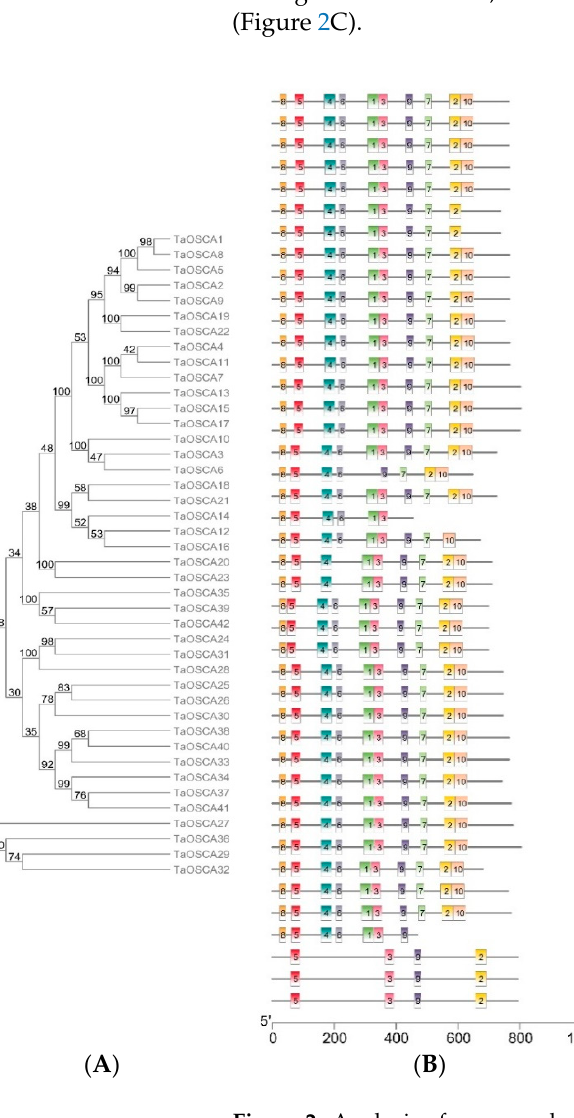
Figure 2. Analysis of conserved motifs and gene structure of T. aestivum OSCA genes. ( A ) Phylogenetic tree constructed using the TaOSCA protein sequences. ( B ) Ten types of conserved motifs predicted in the TaOSCA protein sequences. The different motifs are shown in different color boxes. The sequence information for each motif is provided in Supplementary Table S2. ( C ) The gene structure of TaOSCA members. Untranslated regions, exons, and introns are shown as green boxes, yellow boxes, and horizontal lines, respectively.